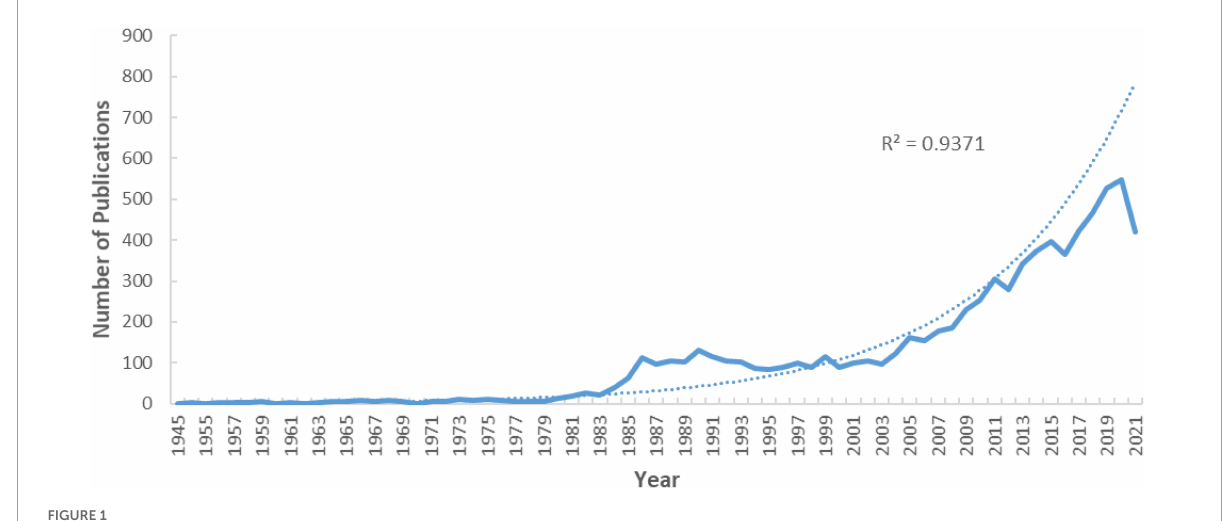
FIGURE1 Publication years and growth